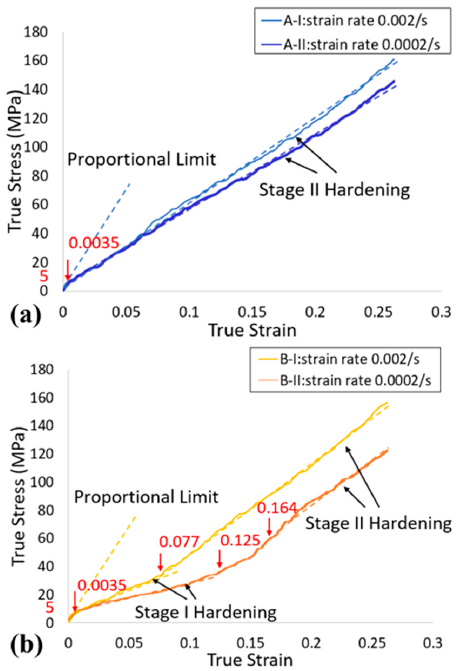
Figure 7. The flow curve for crystals with orientation A ( a ) and orientation B ( b ) compressed at the strain rate of 0.002/s (A-I and B-I) and 0.0002/s (A-II and B-II).